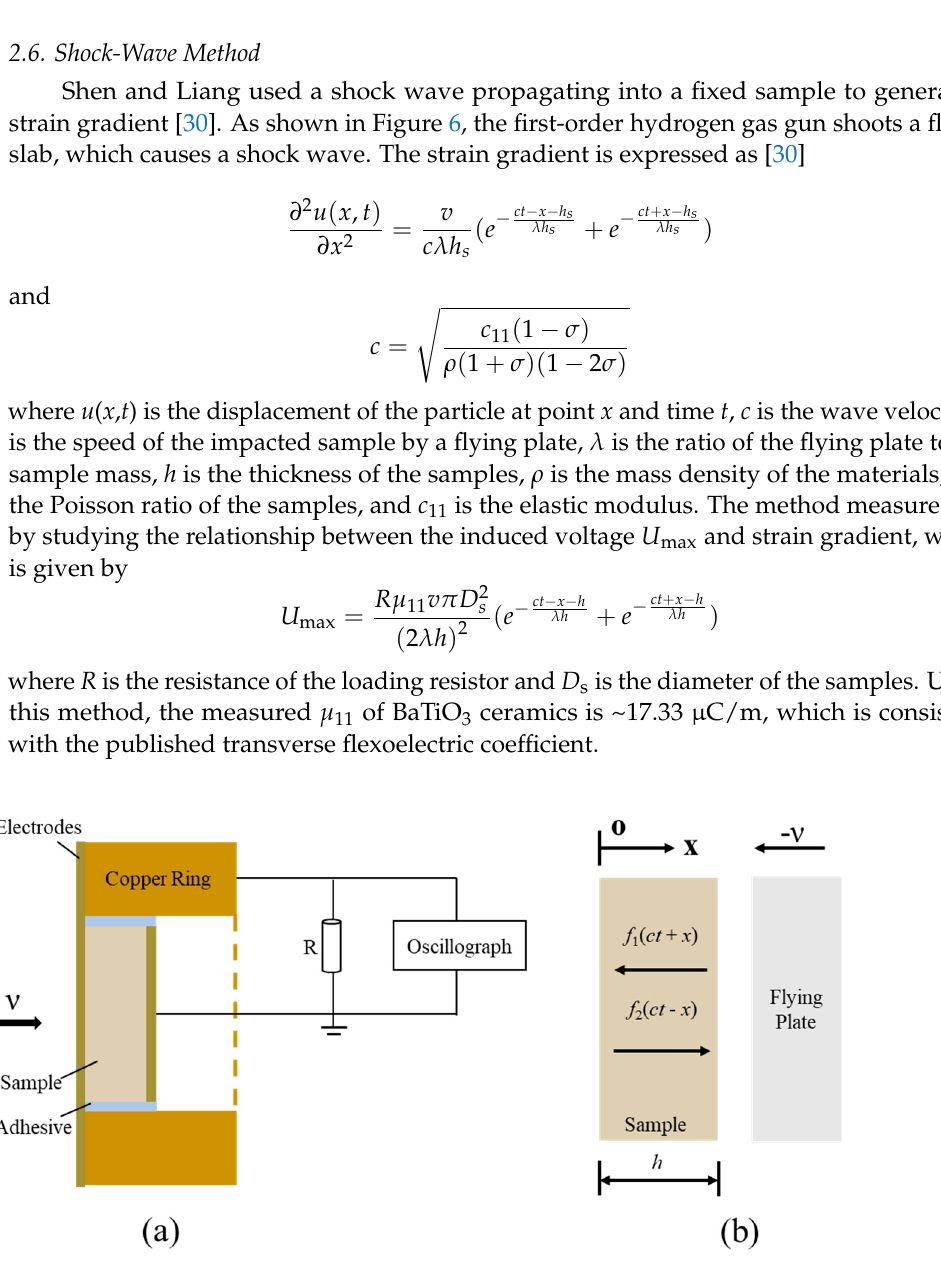
Figure 6. ( a ) Schematic of the sample configuration and the one-dimensional shock-wave experiment. ( b ) The theoretical model of the shock-wave experiment.